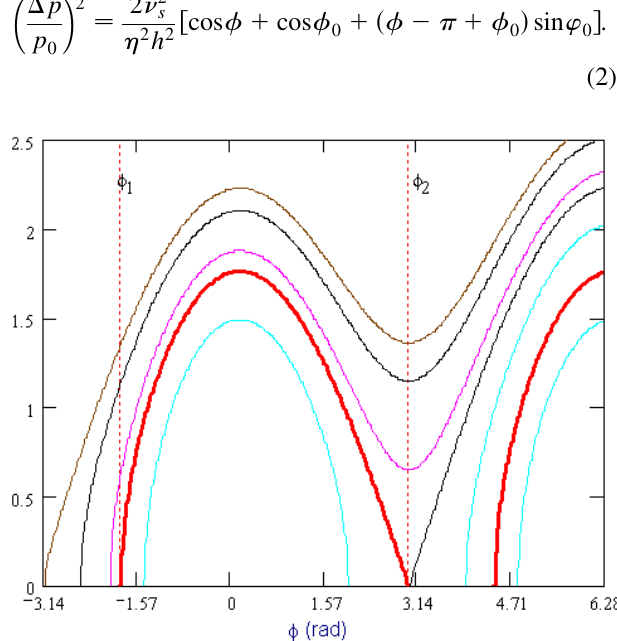
FIG. 1. (Color) Upper half of phase space trajectories in the vicinity of the separatrix (red line) for (cid:4) spread (vertical axis) is presented in units of (cid:6) (cid:3)h=(cid:2)